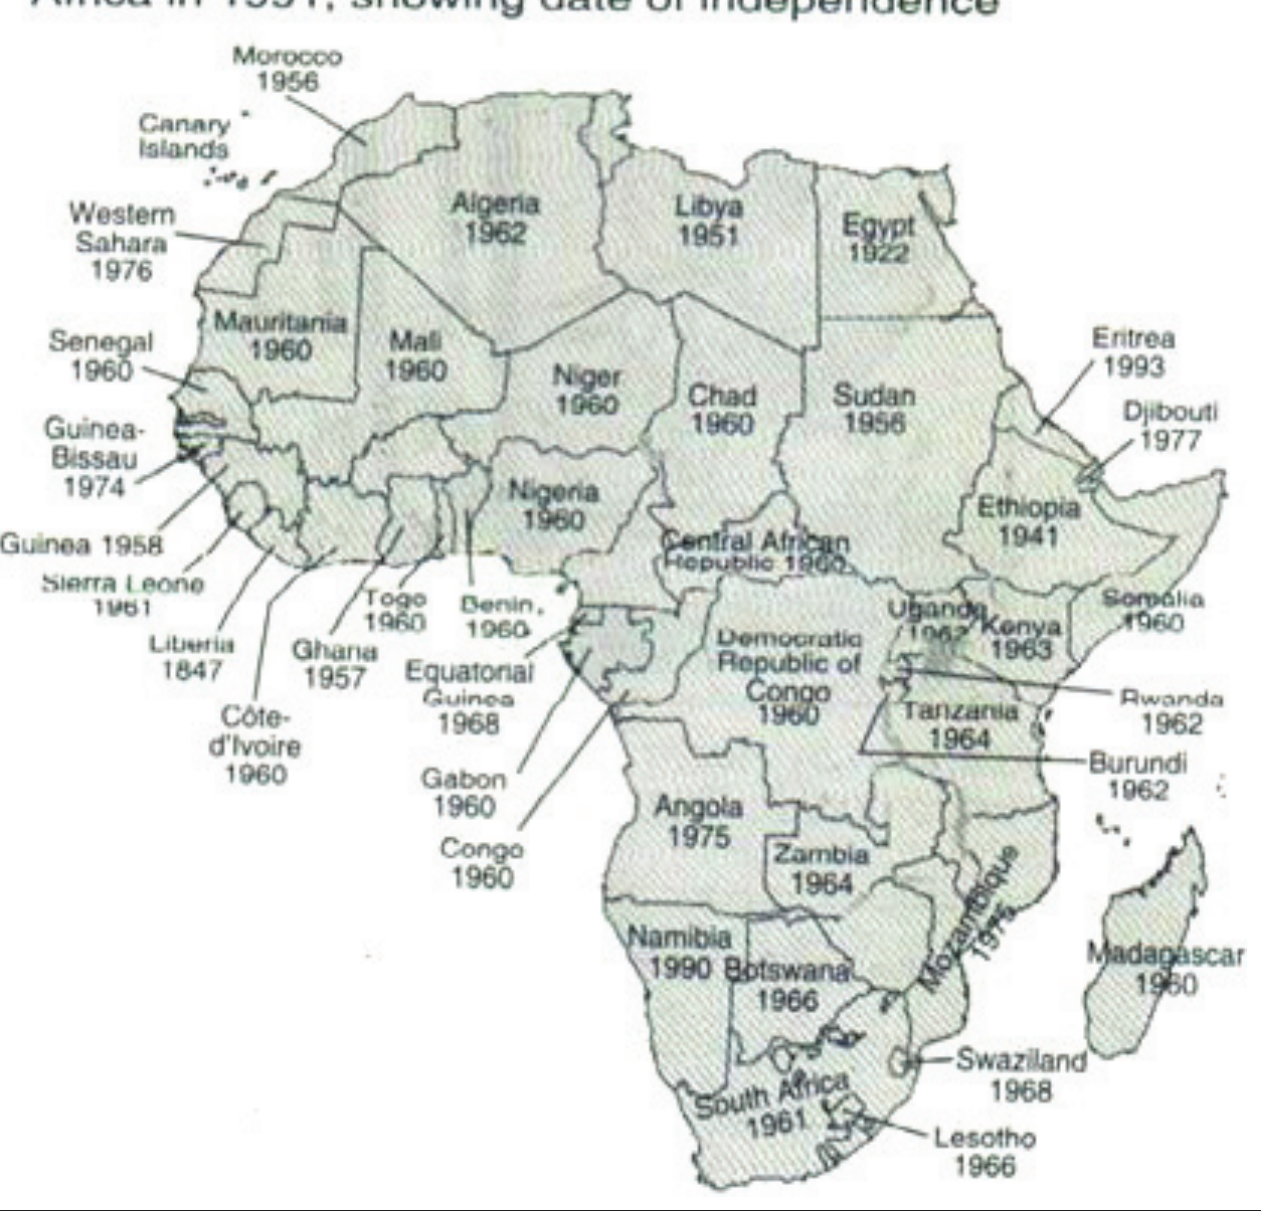
FIGURE 1: Map of